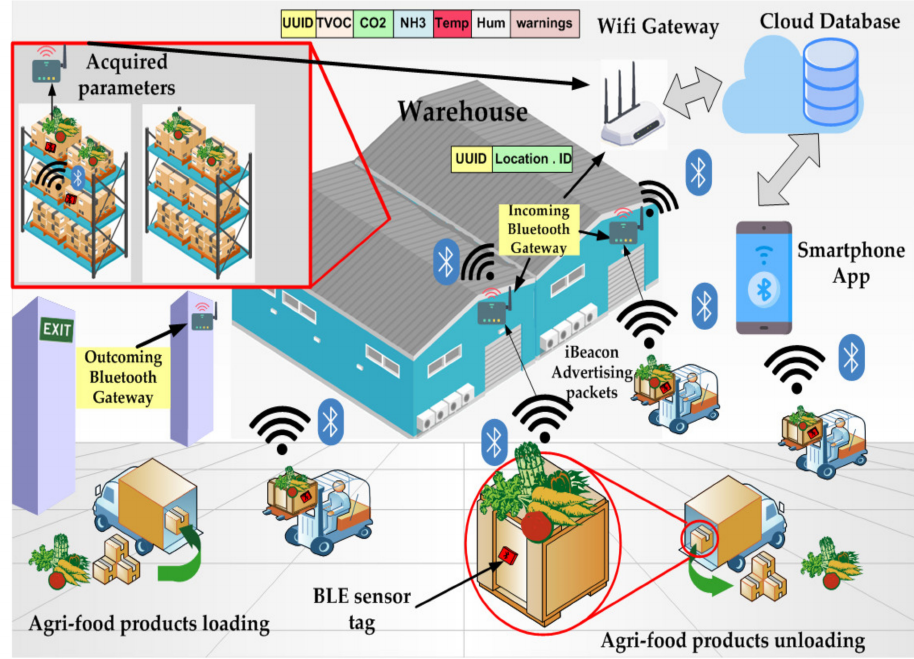
Figure 20. Schematic representation of the proposed tracking and tracing system based on the BLE smart